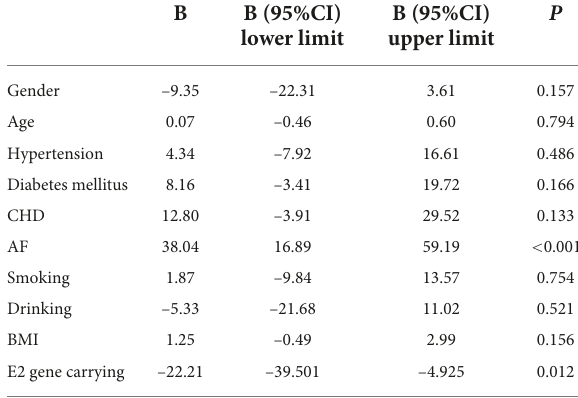
TABLE 4 Analysis of factors influencing the LDL-C reduction rate following atorvastatin